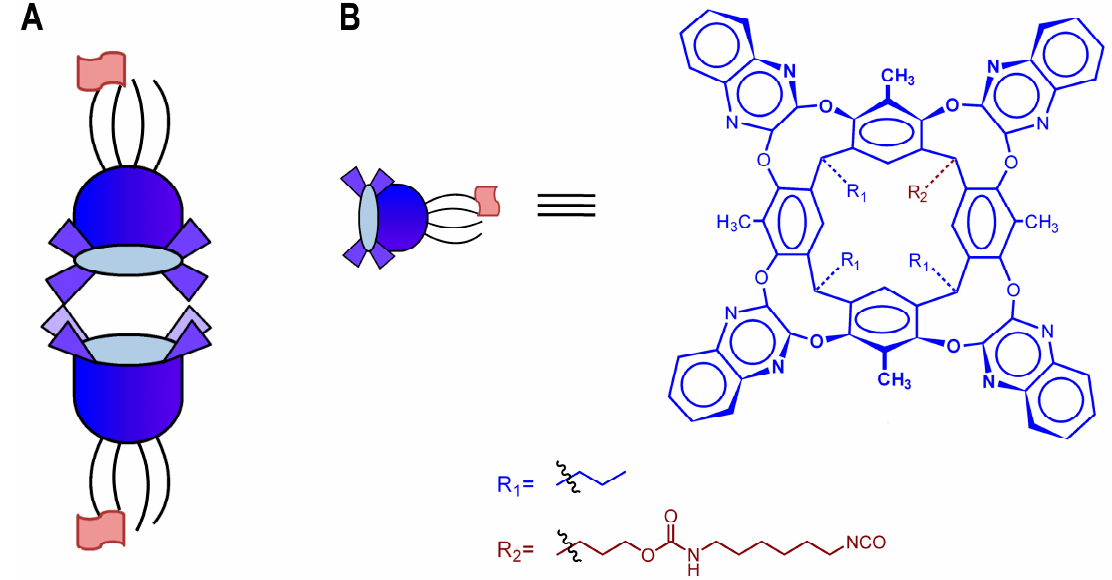
Figure 1. A : Illustration of dimerization of self-complementary velcrand. B : Structure of self-dimerizing velcrand with isocyanate chain for introduction into functional polymers.